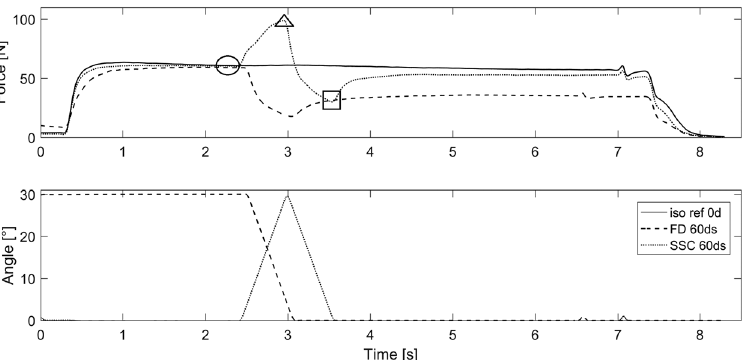
Figure 2. Thumb adduction force (top) and metacarpophalangeal joint angle (bottom) as a function of time for an isometric reference contraction (solid line, Ref_Isometric), a pure shortening-induced force depression (dashed line, FD_60°/s) and a stretch-shortening-cycle at 120°/s (dotted line, SSC_120°/s). The force before stretching (b-STR; • ), the maximum force at the end of the stretch (e-STR; ▲ ), the minimum force at end of shortening (e-SHO; ■ ) and the average isometric steady-state force (500 ms) prior to muscle deactivation were